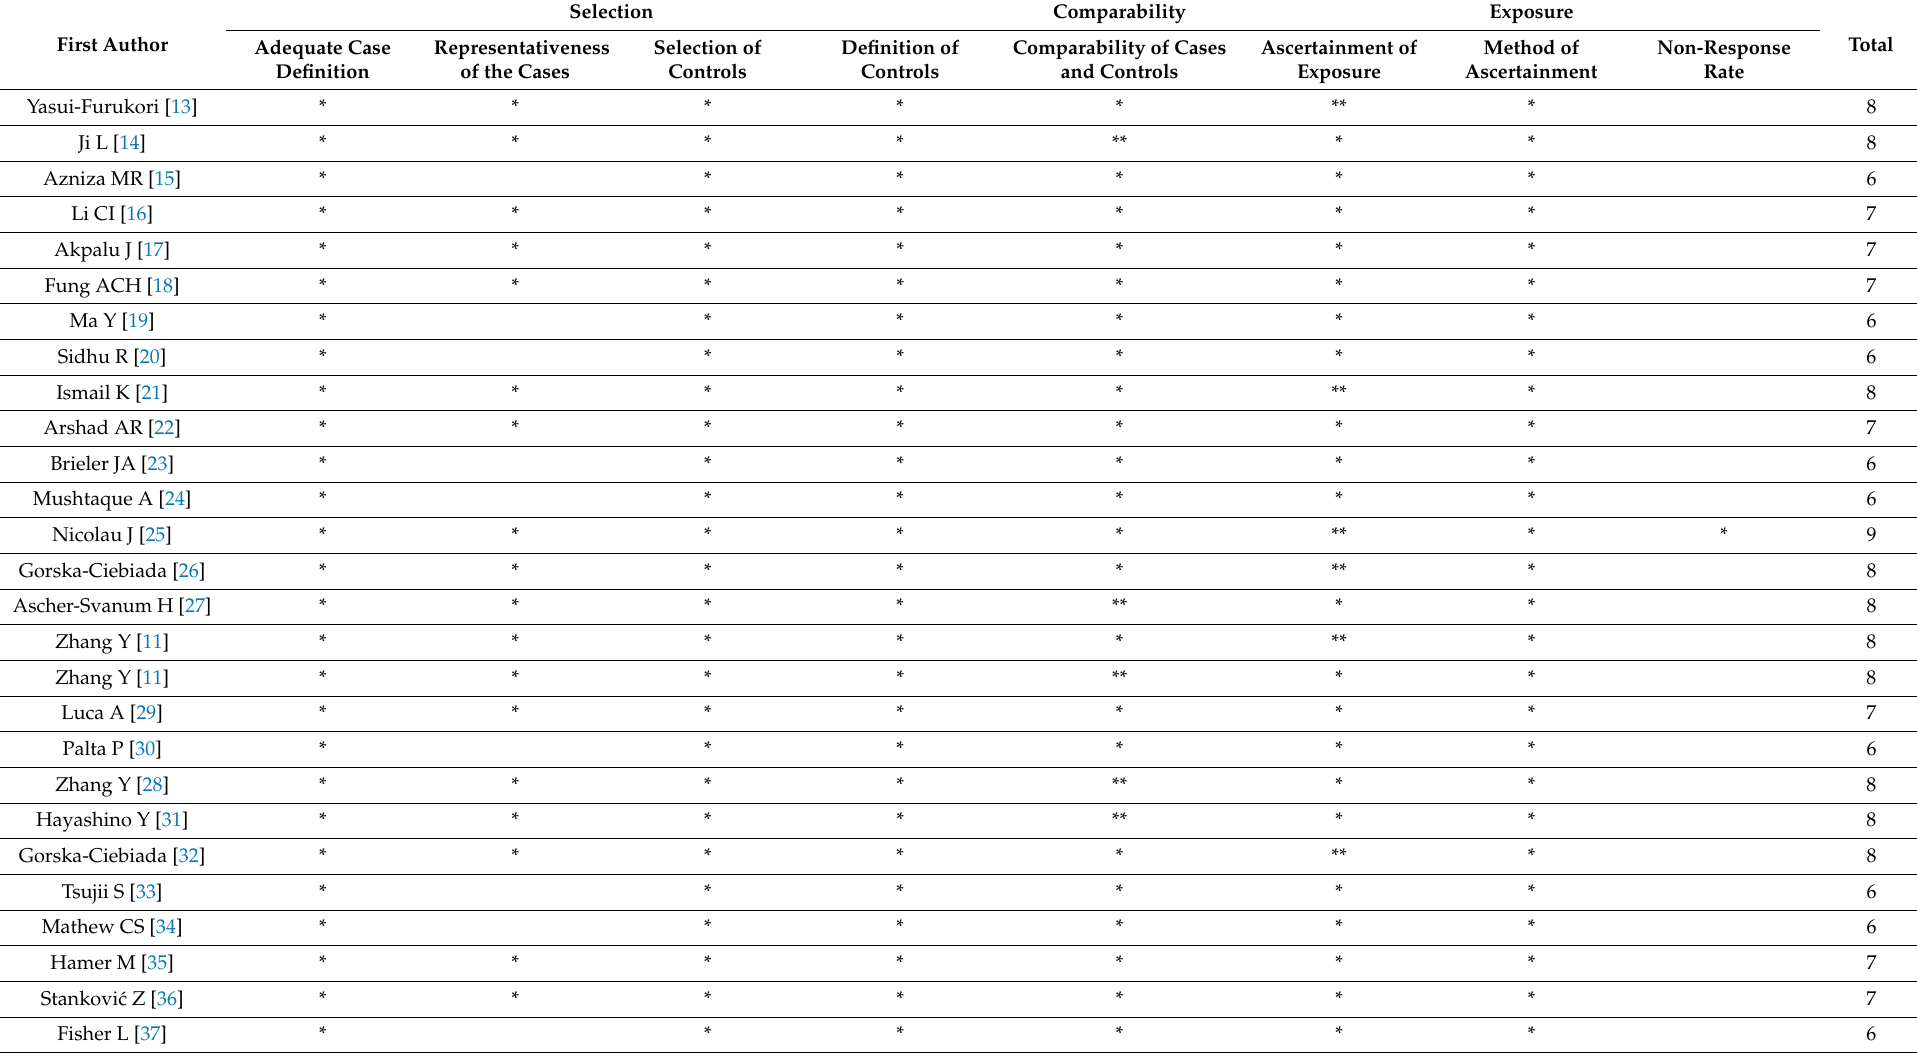
Table 2. Quality assessment of the studies included based on the Newcastle-Ottawa